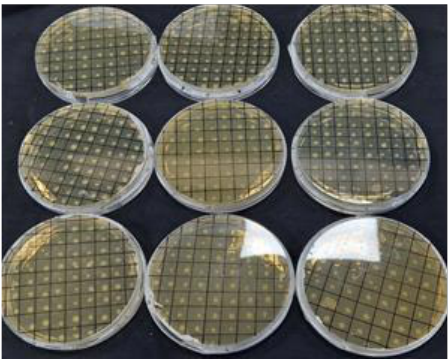
Figure 8. Axenic culture of subgenomic library of rice. Putative recombinant clones (white colonies) were restreaked on LA+ carbenicillin (100 µg/mL) grid plates supplemented with X-Gal +IPTG for α -complementation. Bonafide white colonies (representing recombinant clones) after two rounds of subculturing were stored individually for long-term storage.